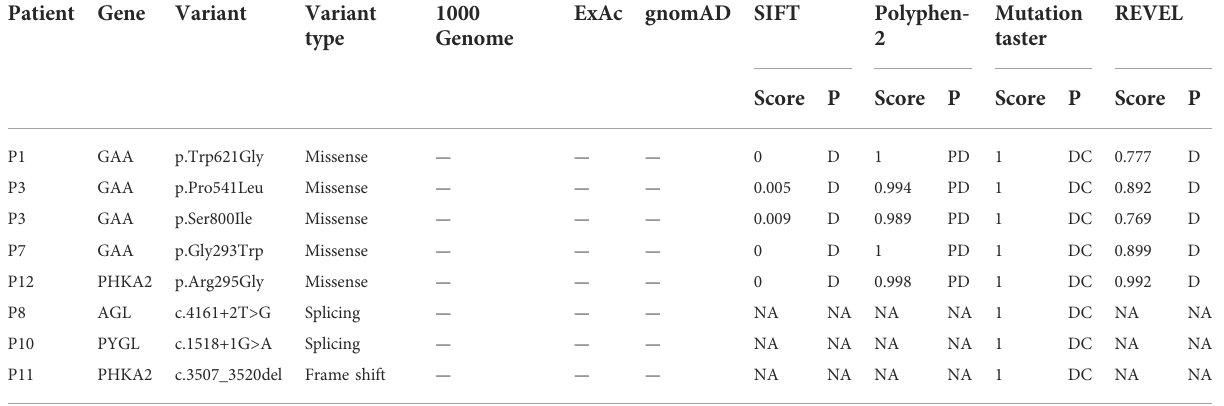
TABLE 4 | Effect on protein function of the novel variations predicted by SIFT, PolyPhen-2, MutationTaster, and REVEL. Patient